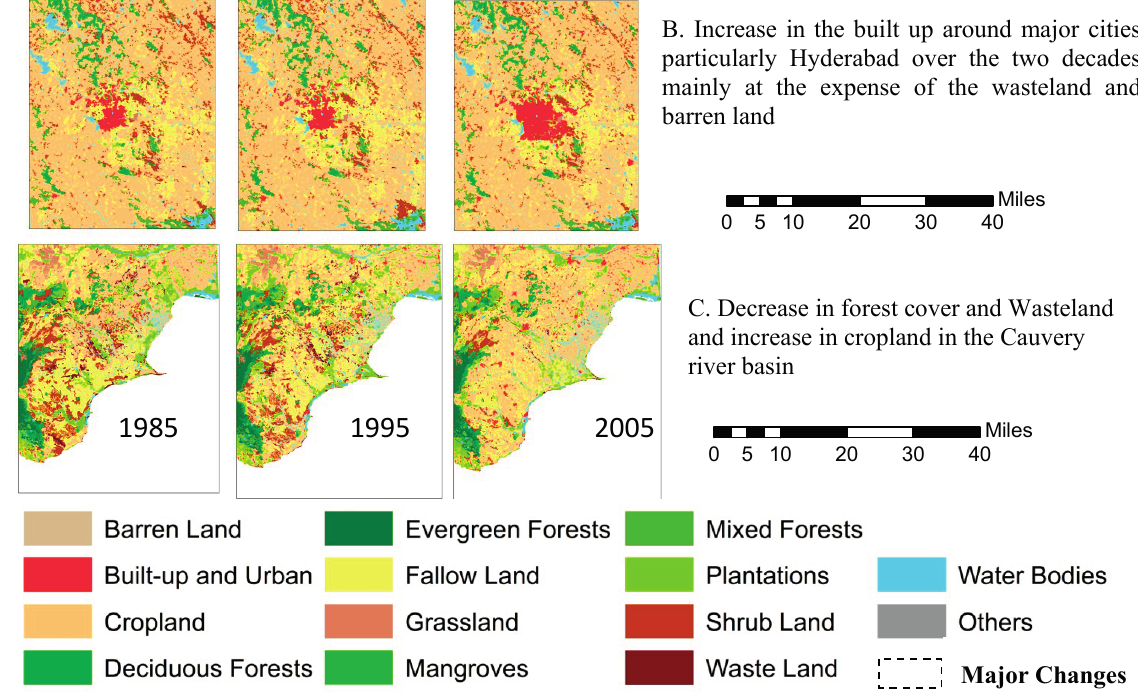
Figure 4. Land-use and land-cover changes in south India over the two decades (1985 – 2005). ( A ) Decrease in the vegetation cover to agriculture in Maharashtra and Madhya Pradesh. ( B ) Increase in the built up around major cities particularly Hyderabad over the two decades mainly at the expense of the wasteland and barren land. ( C ) Decrease in forest cover and Wasteland and increase in cropland in the Cauvery river